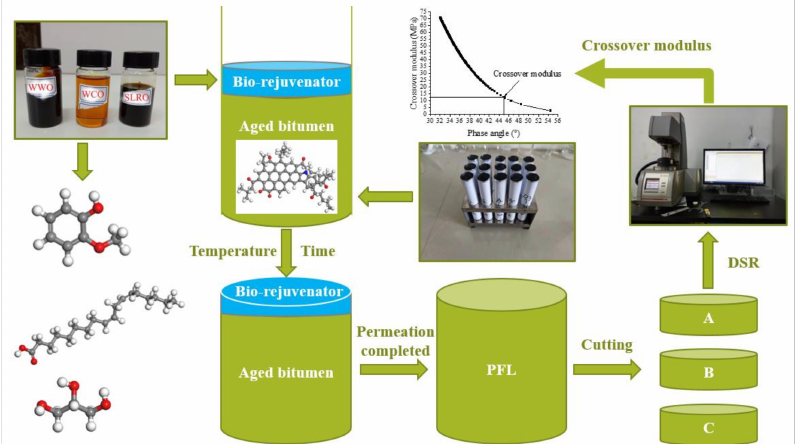
Figure 26. Preparation of PFL.